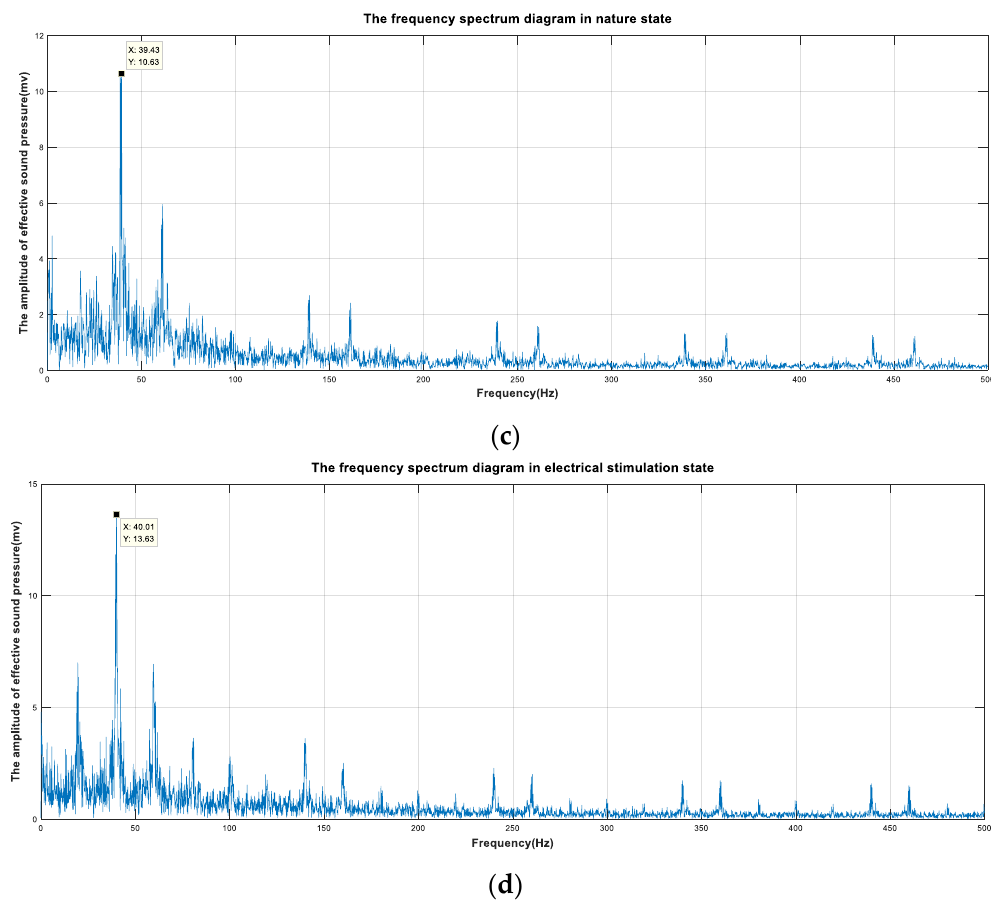
Figure 7. The time-domain and frequency-domain analysis of the wings flapping. ( a ) The time-domain diagram of the wings vibration signals in electrical stimulation state (the blue arrow indicates the beginning of the electrical stimulation, and red and black arrows indicate the start and end of beetle flapping its wings respectively); ( b ) the photograph of wings flapping; ( c , d ) the frequency spectrum diagrams of the wings vibration signals in nature state and electrical stimulation state. Table 1. Sampling data of two beetles for 10